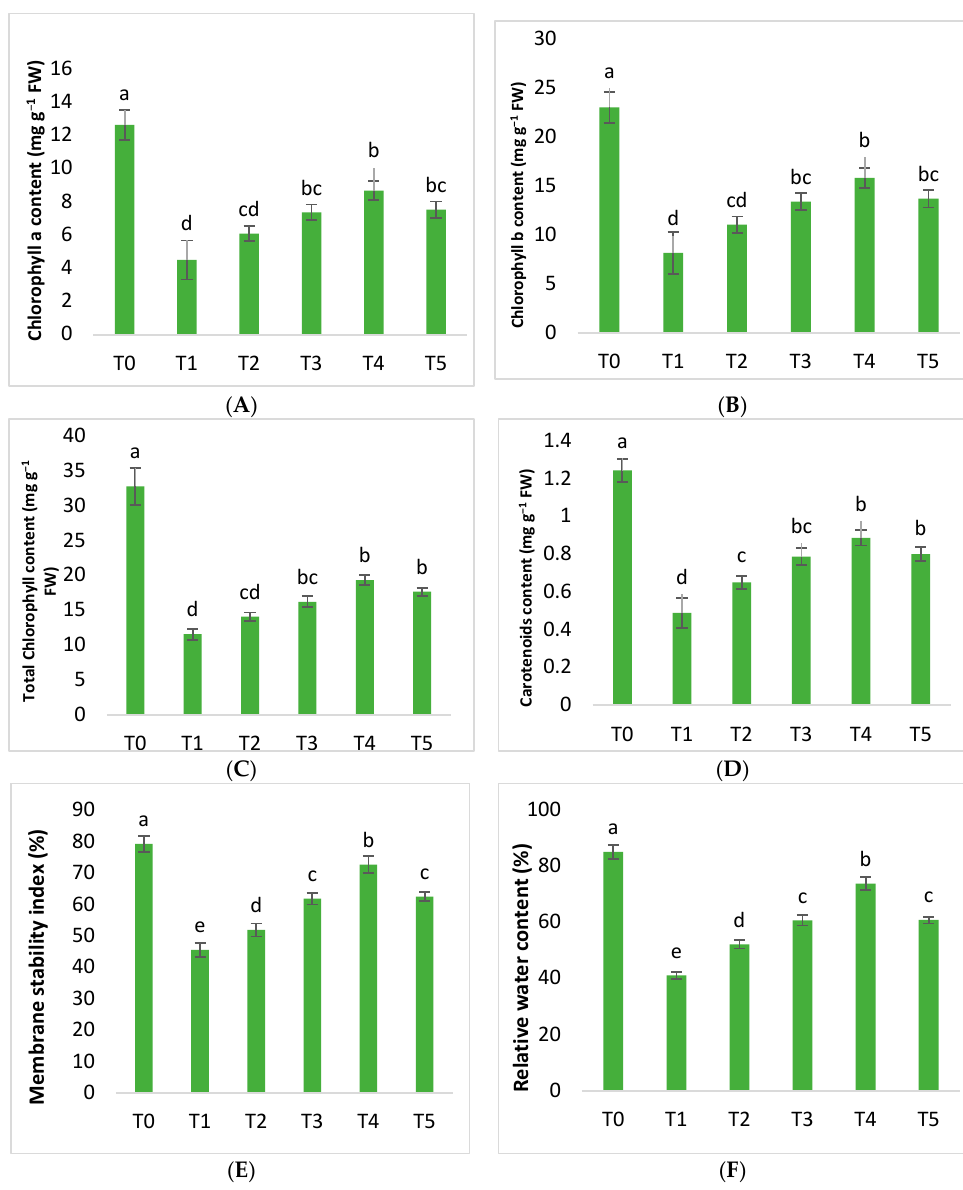
Figure 6. Differential effects of plant-based silver nanoparticles on ( A ) chl a, ( B ) chl b, ( C ) total chl, ( D ) carotenoid content, ( E ) RWC, and ( F ) MSI. (a mesns best than and b means best in second order and so on).